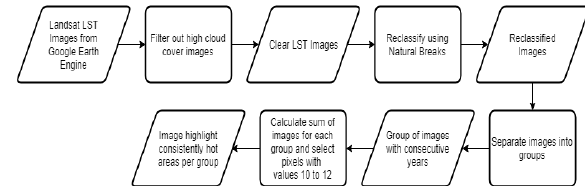
Figure 3. Hotspot detection workflow applied to the generated Baguio City LST layers from Landsat (1998 to 2019) Group Years Included